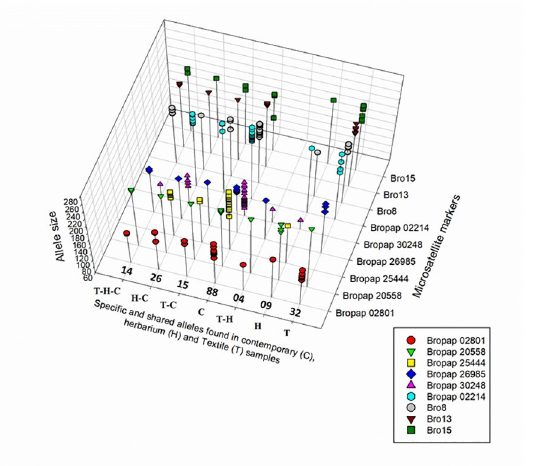
Fig 3. SSR alleles found in textile, herbaria and contemporary paper mulberry samples. 3D scatterplot of alleles found in contemporary plants (C), herbaria (H) and textile samples (T). The X-axis shows alleles that are specific or shared among the different types of samples. The number of alleles is indicated in each case. The Y-axis indicates allele sizes for each marker and sample type. The Z-axis shows the alleles found for each microsatellite